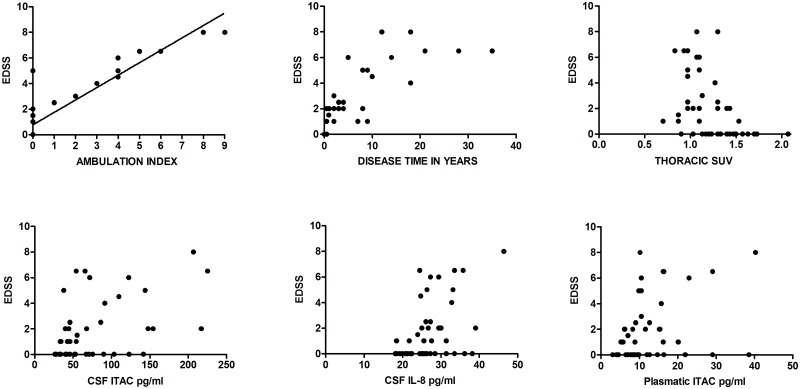
The graphs represent the clinical correlation measured by the EDSS score with other variables of interest.